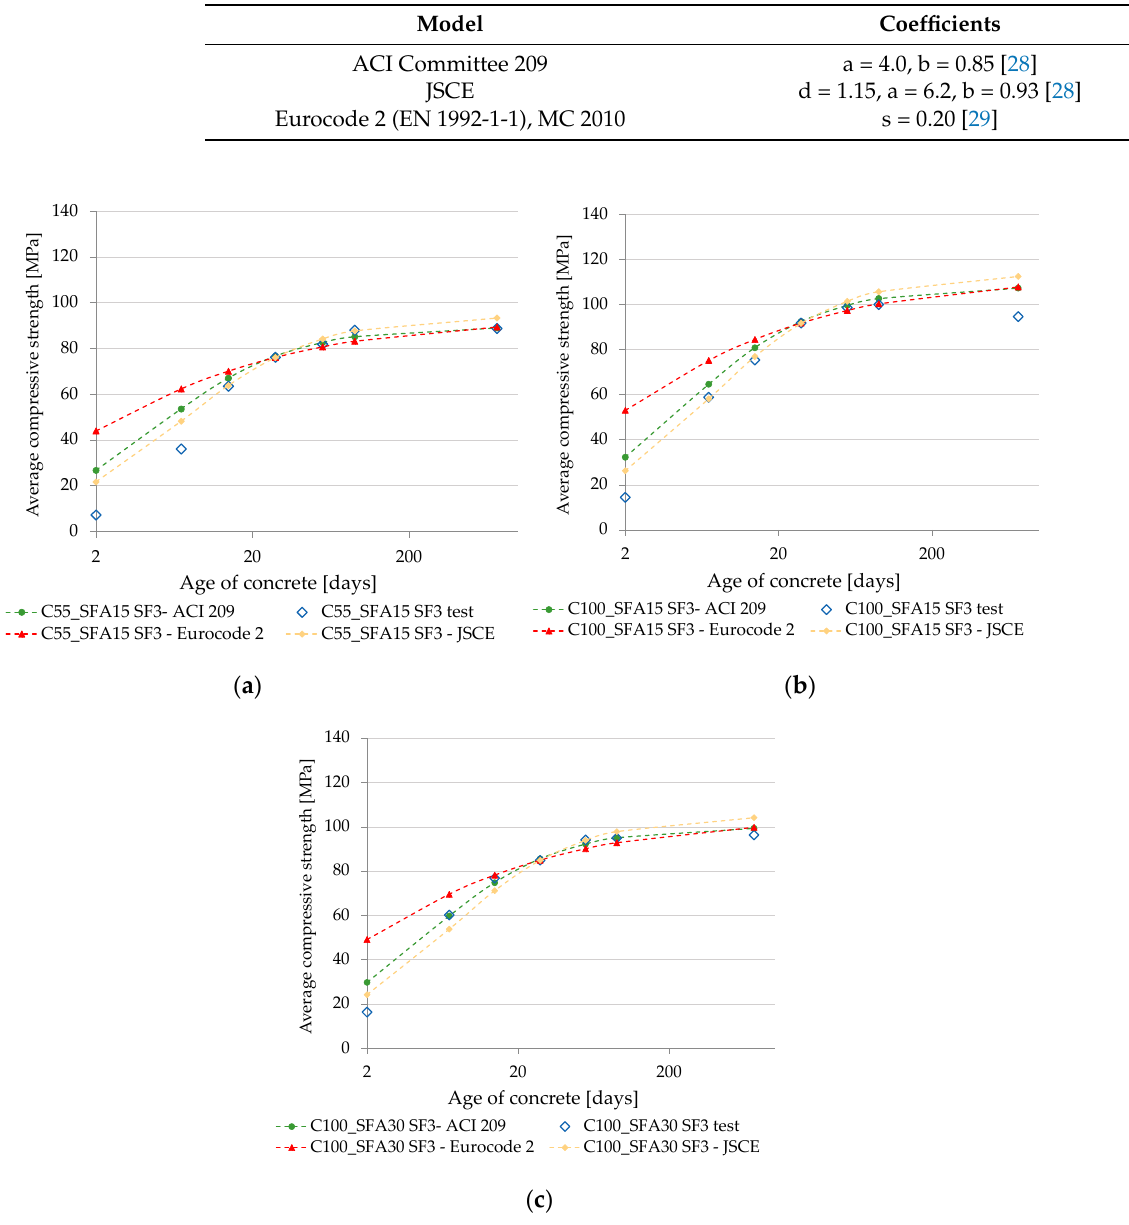
Table 5. Coefficients applied in time-dependent compressive strength development models.